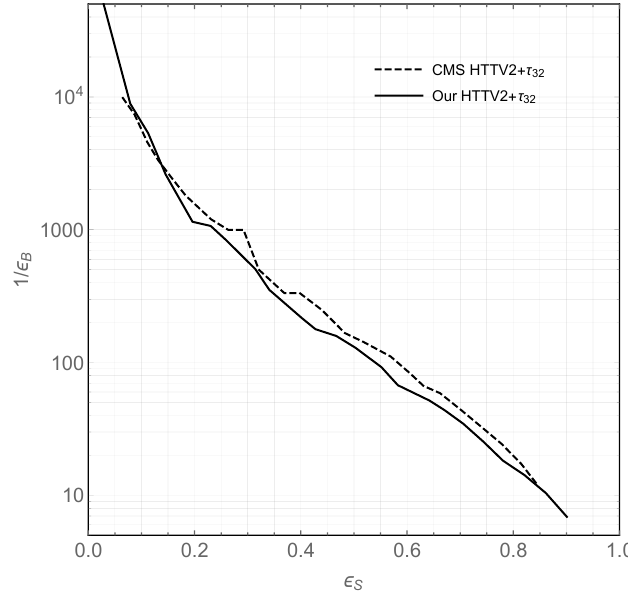
Figure 10 . ROC curves validating our implementation (solid) of the HTTV2+N-subjettiness cut- based tagger described in [42]. The CMS curve (dashed) was digitized from (cid:12)gure 7R of [42]. We see that the agreement is pretty